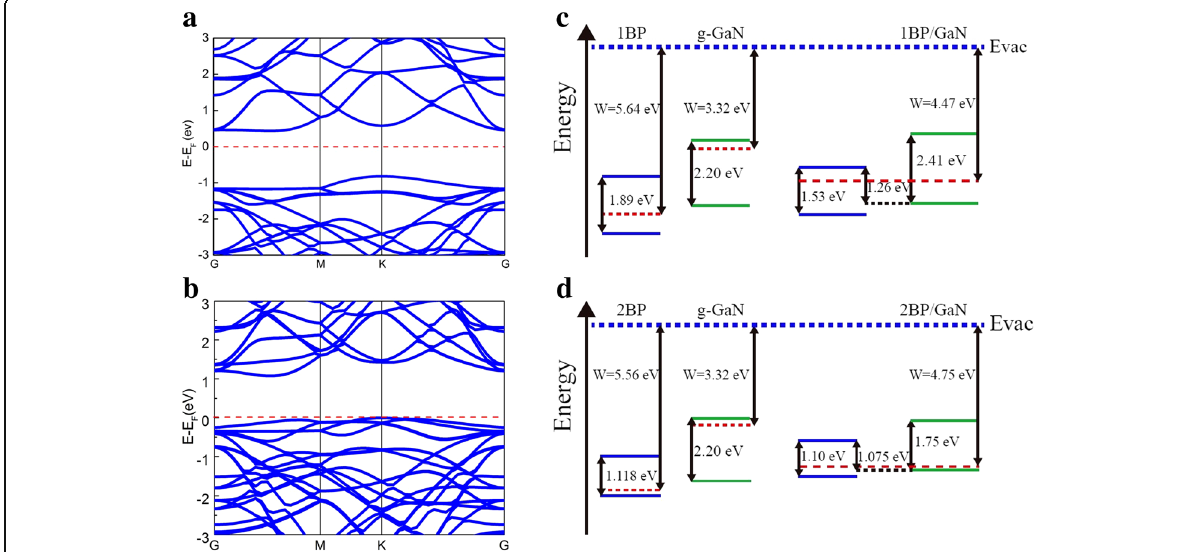
Fig. 2 Band structures of a monolayer-blue-P/g-GaN heterostructure, and b bilayer-blue-P/g-GaN heterostructure, respectively; band alignments and work functions related to c monolayer-blue-P/g-GaN heterostructure and d bilayer-blue-P/g-GaN